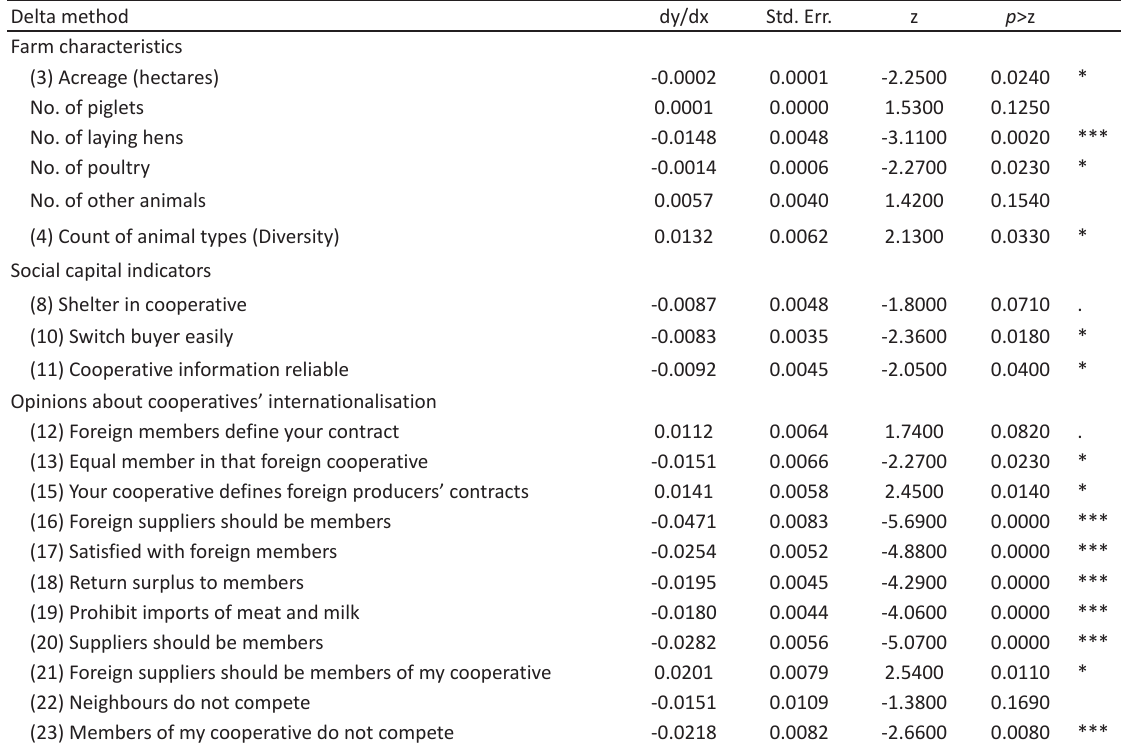
Table 3: Marginal effects ( dy/dx ) from an ordered logit model (model 4): Dependent variable = ‘My cooperative must invest for